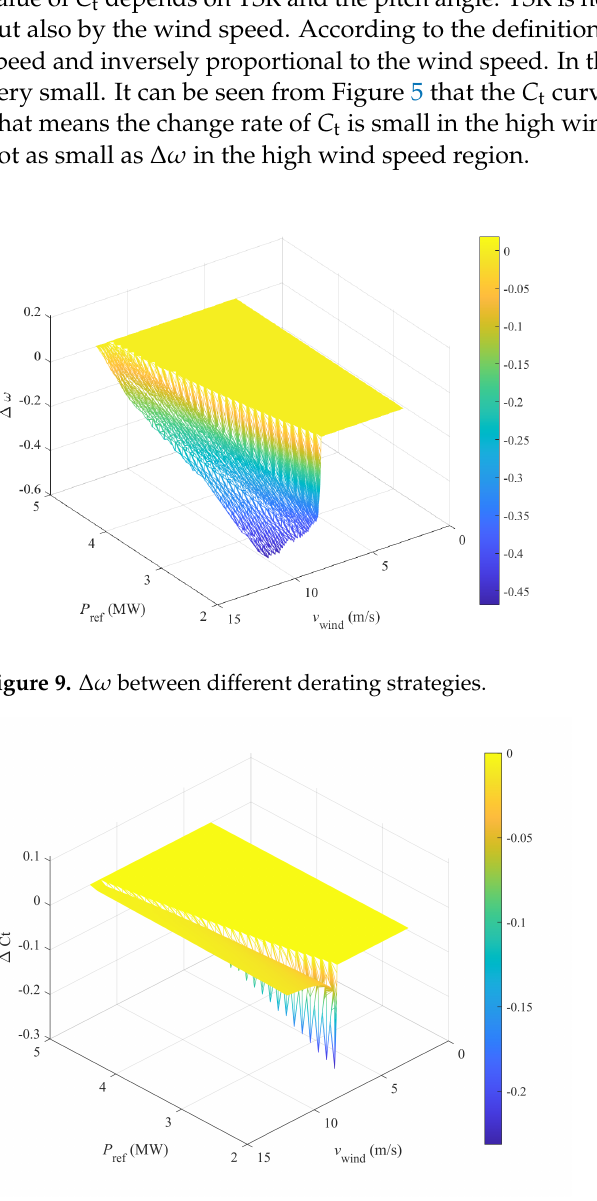
Figure 10. ∆ C t between different derating